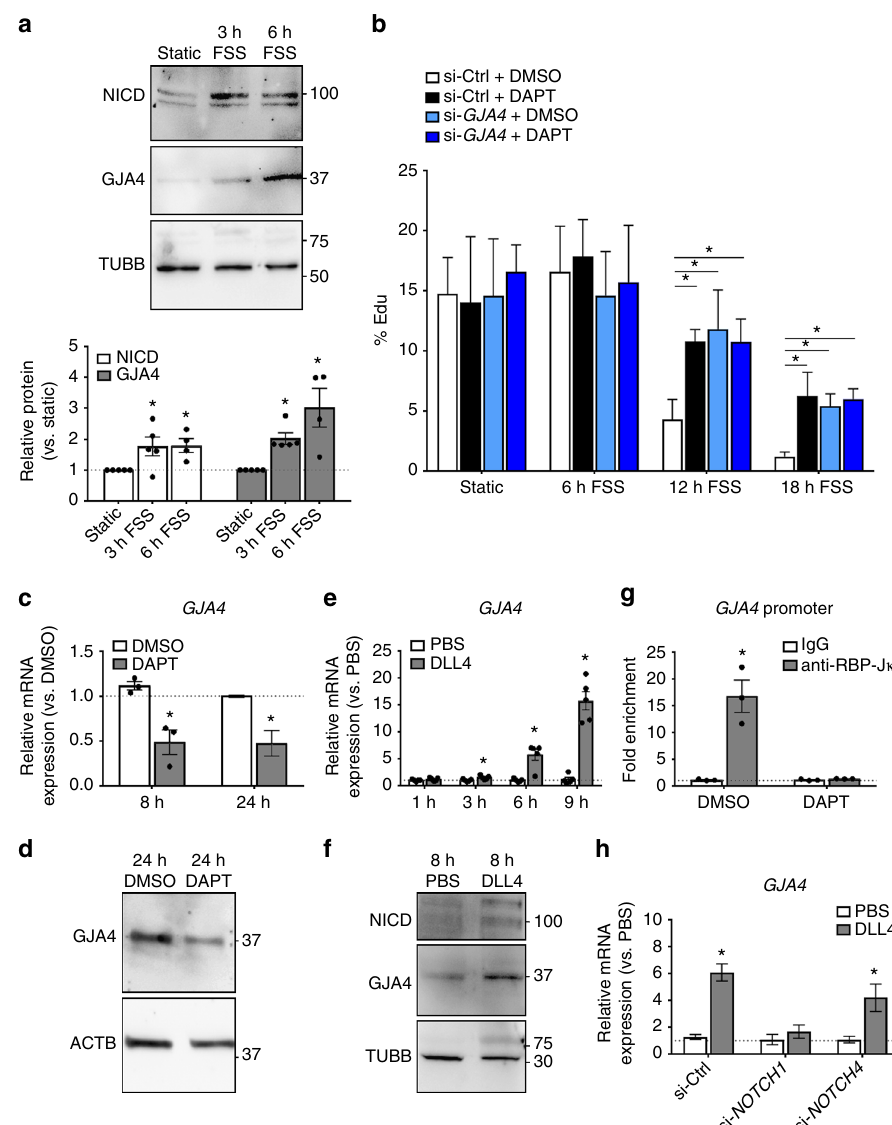
Fig. 2 Shear-sensitive NOTCH upregulates GJA4 expression. a Exposure of HUVEC to 6 h FSS signi fi cantly upregulated GJA4 protein, in parallel with sustained increase in NICD (mean densitometry ± SEM; n = 5 (Static, 3 h FSS), n = 4 (6 h FSS); one-way ANOVA: p = 0.04 (NICD), p = 0.004 (GJA4), asterisks indicate p < 0.05 in post hoc t -test vs. Static). Uncropped blots presented in Supplementary Fig. 3. b si- GJA4 and DAPT (alone or in combination) abrogated fl ow-induced suppression of EdU incorporation at 12 – 18 h shear (mean % EdU-positive nuclei ± SEM for 8 ROI; representative of n = 3 experiments; one-way ANOVA: p < 0.0001 (12 h FSS, 18 h FSS), asterisks indicate p < 0.05 in post hoc t -test). c GJA4 levels were reduced by treatment of con fl uent HUVEC with 8 h or 24 h DAPT (mean relative mRNA expression ± SEM vs. DMSO; n = 3 (8 h), n = 5 (24 h); individual values plotted where n < 5; Students ’ t -test: p = 0.01 (8 h), p = 0.006 (24 h)). d 24 h DAPT also reduced GJA4 protein levels in con fl uent HUVEC. Uncropped blots presented in Supplementary Fig. 3. e Seeding of sub-con fl uent HUVEC onto recombinant DLL4 increased GJA4 mRNA levels (mean relative mRNA expression ± SEM vs. PBS; n = 5 for all groups; Students ’ t -test: p = 0.03 (3 h), p = 0.002 (6 h), p < 0.0001 (9 h)). f GJA4 protein and NICD were increased following seeding of sub-con fl uent HUVEC onto Dll4 for 8 h. Uncropped blots presented in Supplementary Fig. 3. g Signi fi cant GJA4 promoter fold enrichment was detected in samples assayed by ChIP using anti-RBP-J κ , compared to IgG controls. This effect was abolished with DAPT treatment (mean fold enrichment ± SEM vs IgG; n = 3 for all groups; Students t -test: p = 0.007 (anti-RBP-J κ )). h si- NOTCH1 , but not si- NOTCH4 , abolished DLL4-induced upregulation of GJA4 mRNA at 6 h following cell seeding (mean relative mRNA expression ± SEM vs. PBS; n = 7 (si-Ctrl, si- NOTCH1 ), n = 8 (si-Ctrl, si- NOTCH4 ); Students ’ t -test: p < 0.0001 (si-Ctrl), p = 0.02 (si- NOTCH4 endothelial G1 arrest and to enable expression of arterial genes. This link between endothelial cell cycle and cell fate was not previously known, and is critically important for controlling blood vessel development and remodeling. Insights gained from